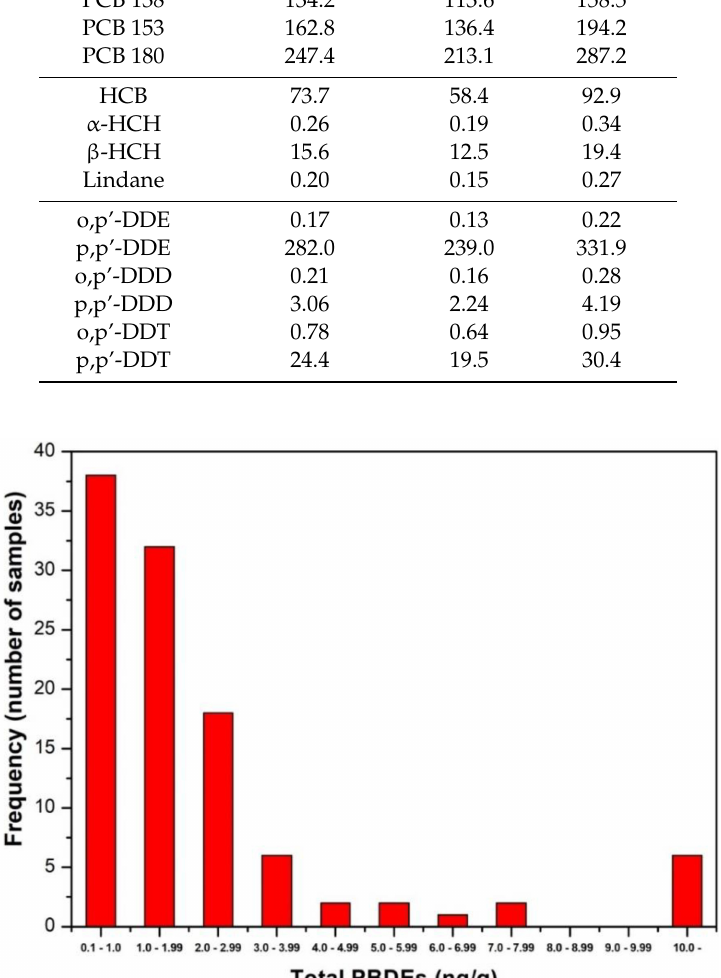
Figure 3. Frequency distributions of the concentrations of PBDEs in human fat